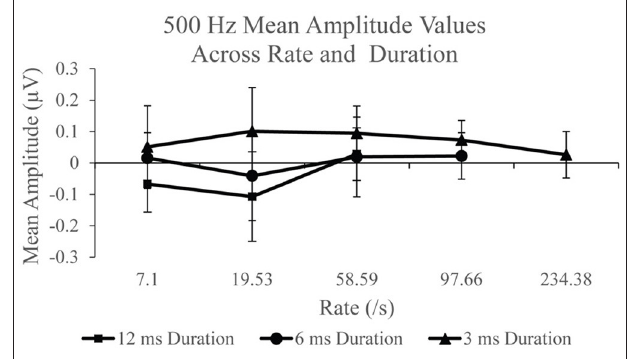
FIGURE 5 | Mean SP amplitude values for the 12 ms duration, 6 ms duration, and 3 ms duration as a function of repetition rate for the 500 Hz condition.